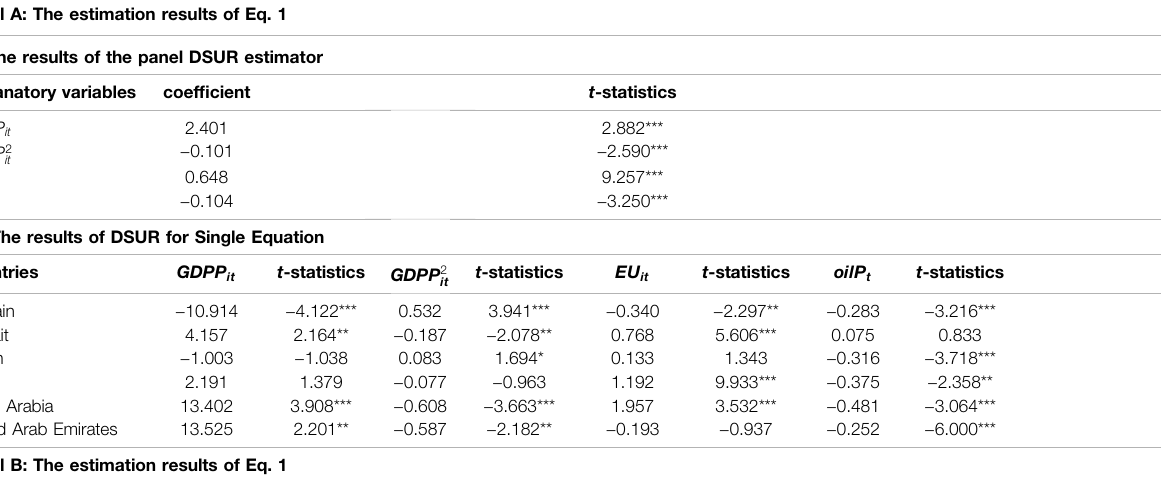
TABLE 7 | Estimation results of Eqs 1 , 4 by panel DSUR estimator. Panel A: The estimation results of Eq. 1 A1: the results of the panel DSUR